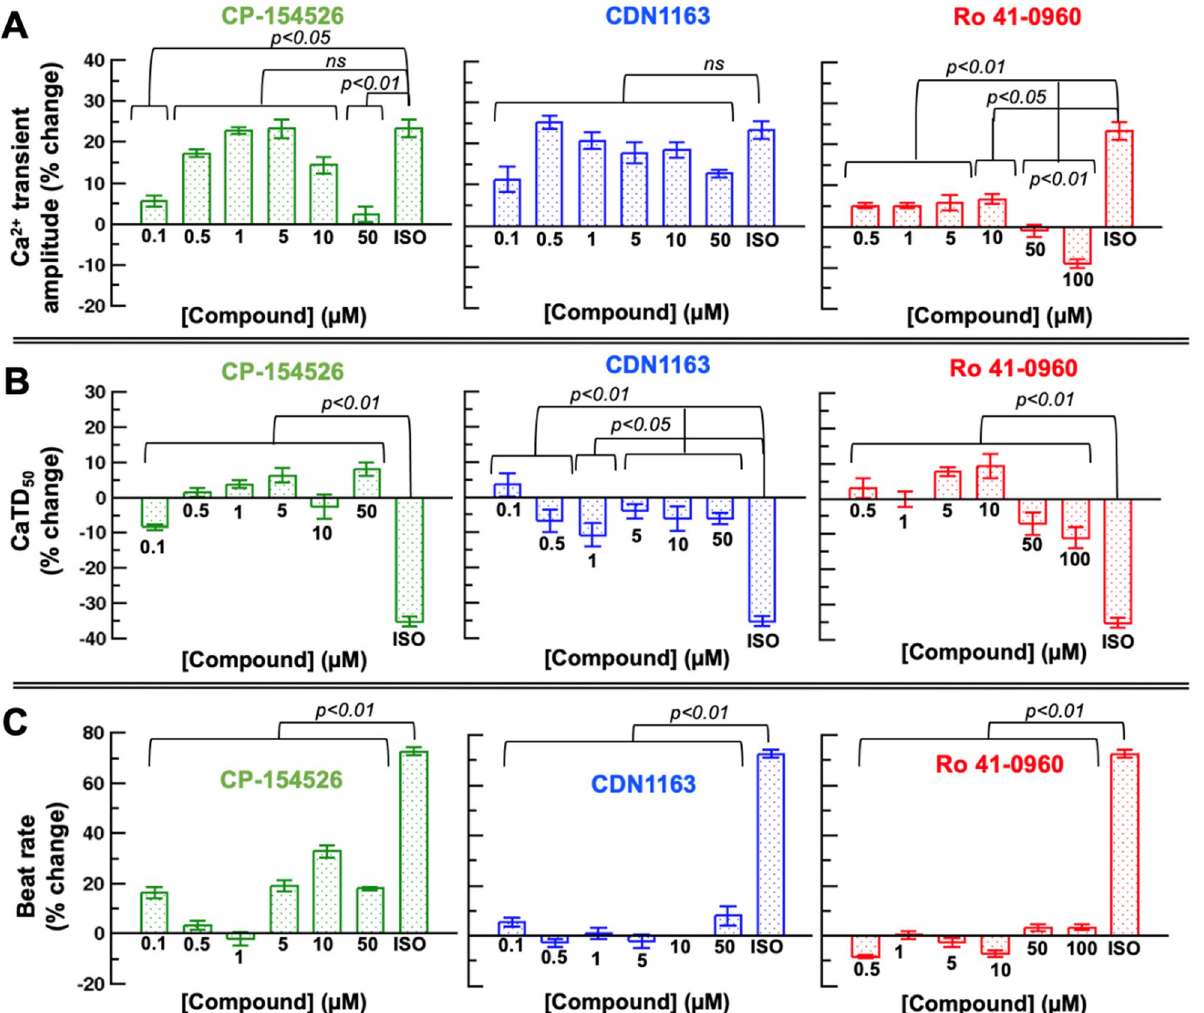
Figure 6. Functional characterization of SERCA2a activators in human iPSC-derived cardiomyocytes. Concentration-dependent effects of SERCA2a activators CP-154526, CDN1163, and Ro 41–0960 on ( A ) the Ca 2+ transient amplitude, ( B ) the Ca 2+ transient duration at 50% recovery (CaTD 50 ), and ( C ) beat rate